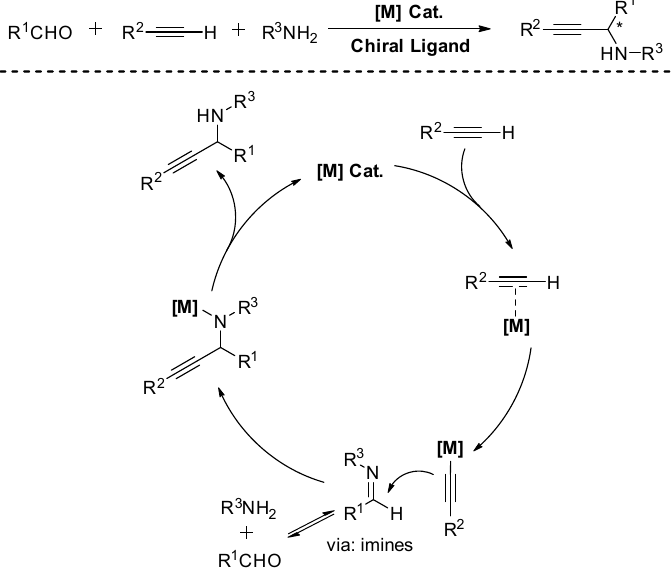
Figure 2. Generalized mechanism of A 3 -coupling with primary amines.